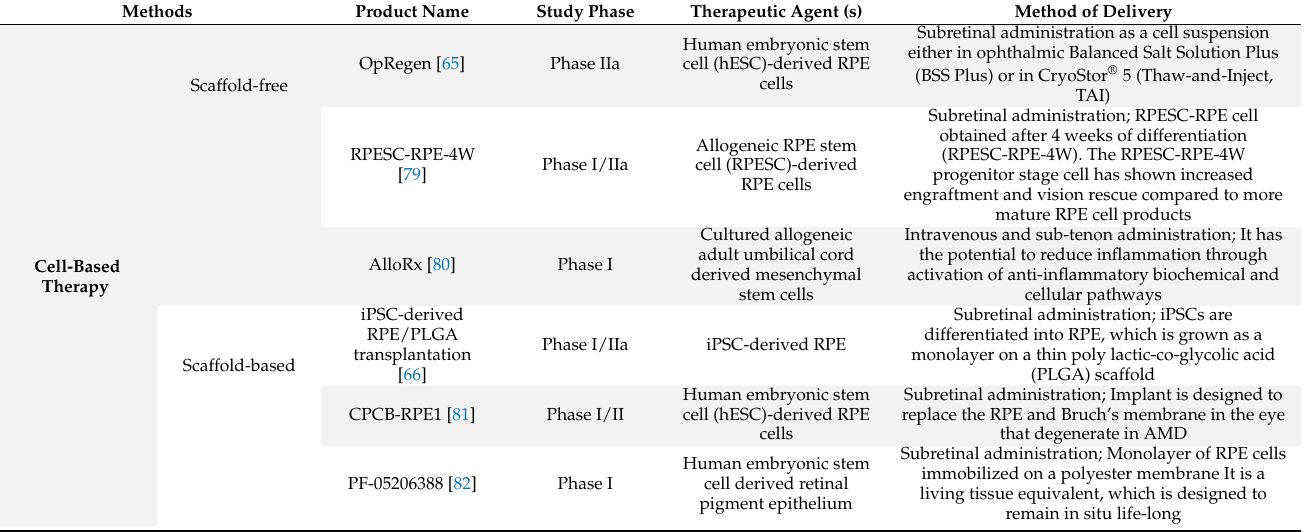
Table 2. List of ATMPs currently undergoing R&D and clinical trials for treatment of AMD. Cell- based therapy includes both scaffold-based and scaffold-free approaches. While subretinal route is the main route of administration for both cell and gene therapy, other delivery methods have also been